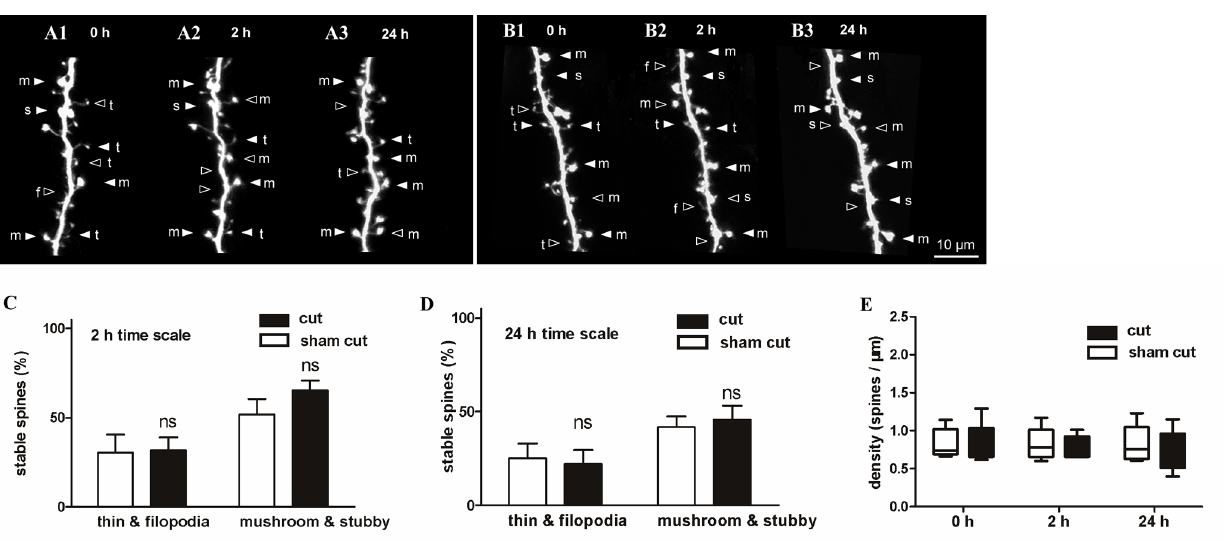
Fig 6. Stability of dendritic spines after olfactory nerve severance. (A, B) Serial time-lapse images showing the morphology of dendritic spines in the sham group (A) and olfactory nerve severance group (B) imaged at 0 h, 4 h, and 24 h, respectively, after surgery. (C, D) Stability of small and large spines after sensory deprivation compared with normal spines during the 2-h and 24-h observation periods. (E) Density of the spines after surgery. Bars indicate means ± SEM. N = 10 neurons with 16 dendrites were used for the sensory deprivation analysis. Significance was set at * P < 0.05, ** P < 0.01, and *** P <